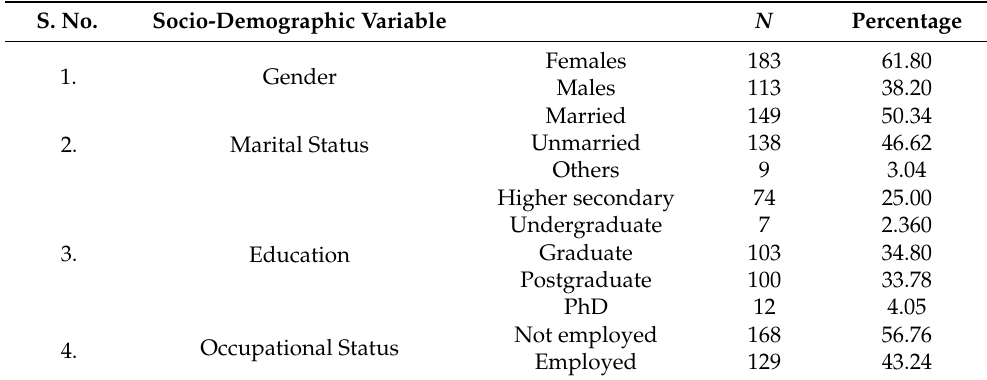
Table 1. Sociodemographic profile of the